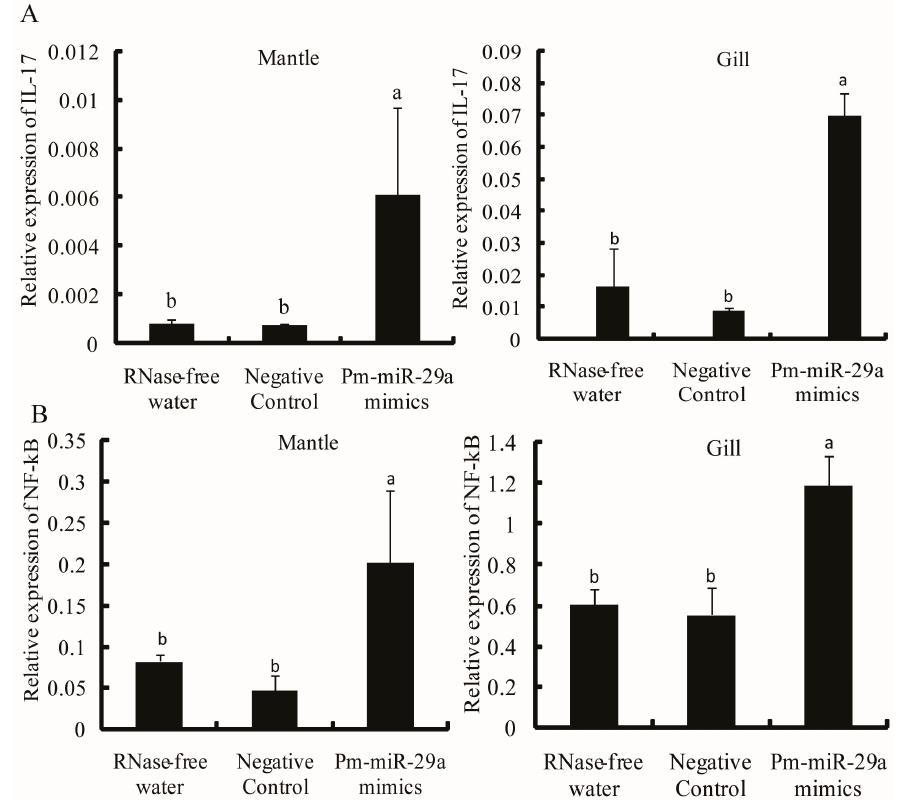
Figure 5. Expression level of the IL-17 and NF- κ B genes after over-expression of Pm-miR-29a. The expression level of IL-17 ( A ) and NF- κ B ( B ) in the mantle and gill were detected by qRT-PCR. GAPDH gene was used as the internal control. Different letters mean a significant difference ( p < 0.05); error bars correspond to mean ± SD.